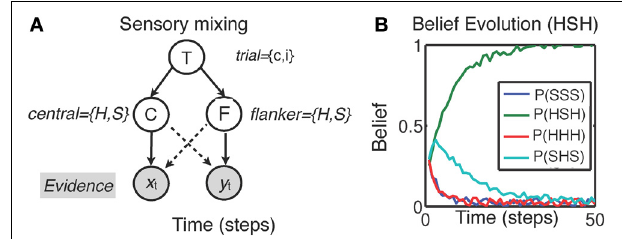
FIGURE 2 | Sensory disambiguation in the Eriksen task (Yu et al., 2009). (A) The model assumes that sensory inputs x t (central stimulus) y t (flanker) are mixed. Responding to the central stimulus C necessitates processing all sensory information and simultaneously decoding both the central stimulus and trial type T ( T = c on congruent trials; T = i on incongruent trials) which depends on disambiguation of central and flanker (F) stimuli; H,S = stimulus type. (B) The corresponding Bayesian inference process (schematic) quickly discovers that the trial has an incongruent stimulus, but decoding the central stimulus identity may take longer due to featural mixing and potentially higher prior expectations of encountering congruent trials (i.e., β > 0 .